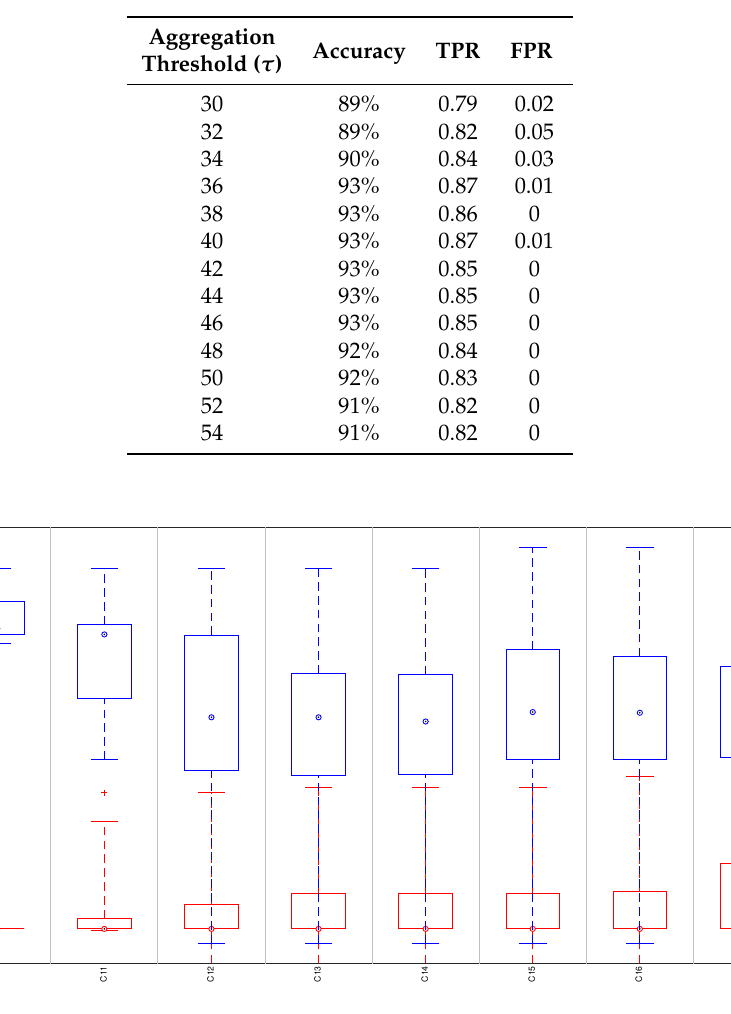
Figure 6. (Best viewed in color) Details of the performance achieved with best aggregation threshold (38) on native stabilized videos. Matching and mismatching statistics are reported in blue and red, respectively, for each